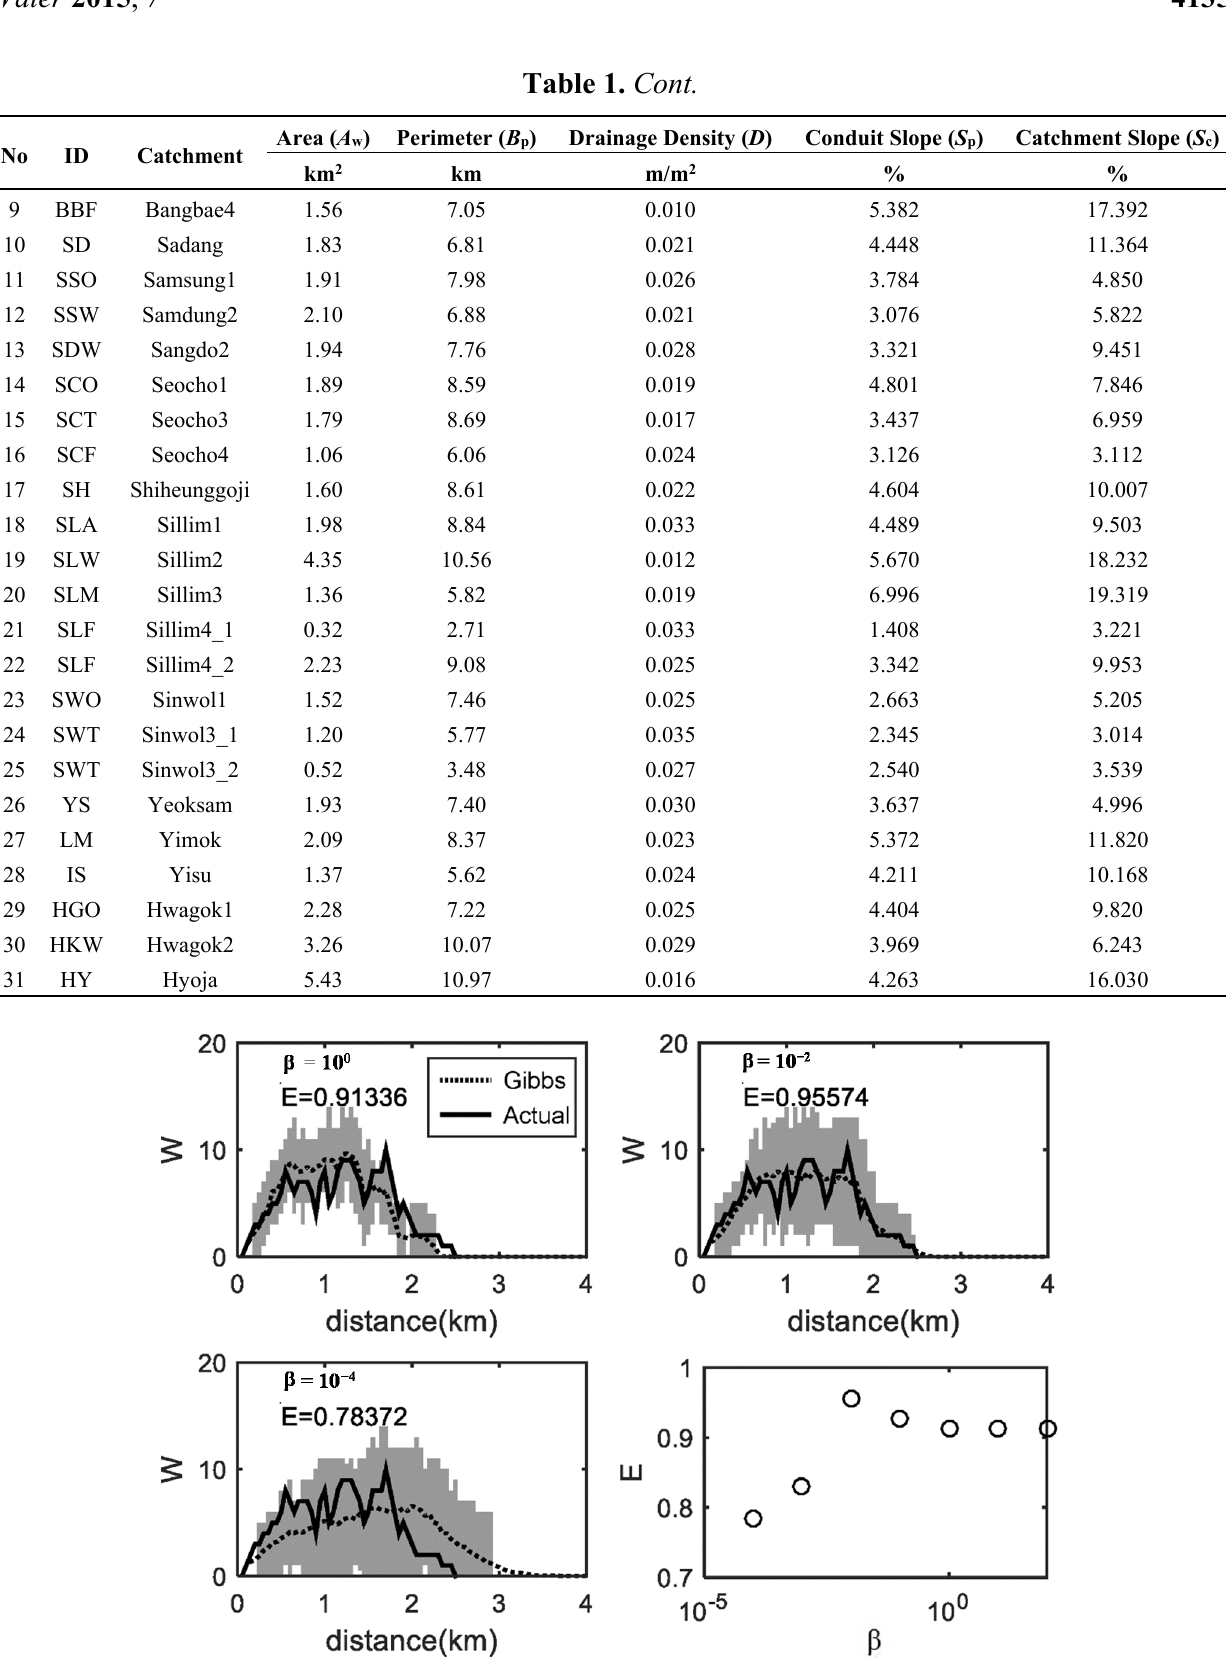
Figure 4. Comparison of the width functions from the actual and simulated drainage networks; the resulting E is plotted as a function of β for a test catchment, BangBae3; the shaded area represents interval between the 25% and 75%